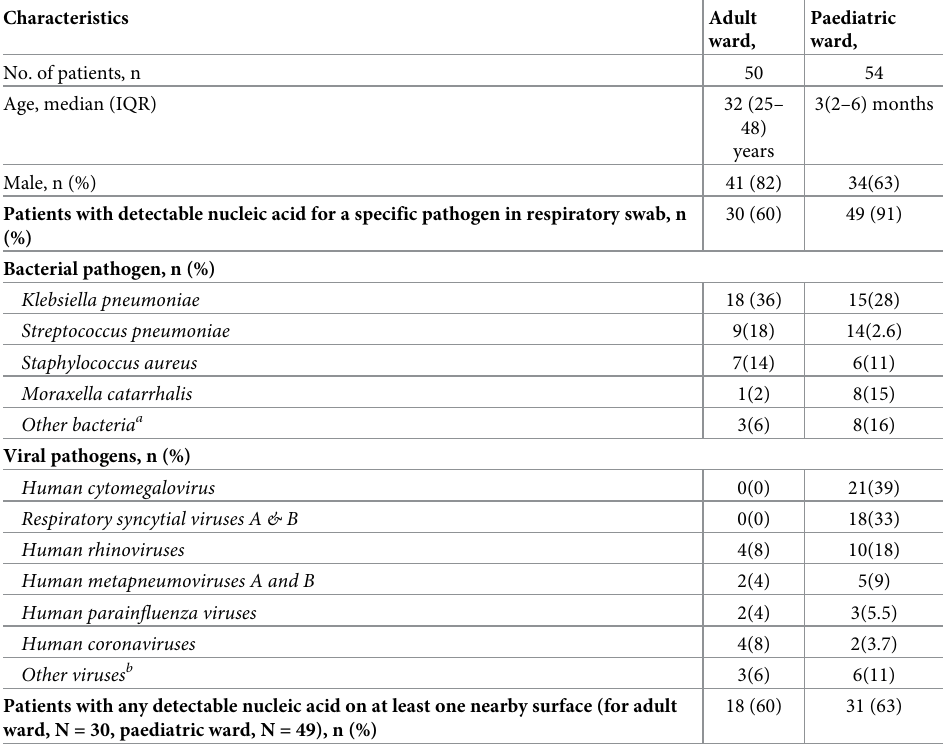
Table 1. Demographic characteristics of study patients and proportion of patients with a detectable nucleic acid for a specific pathogen in respiratory swabs in two tertiary care hospitals in Bangladesh, September-November,